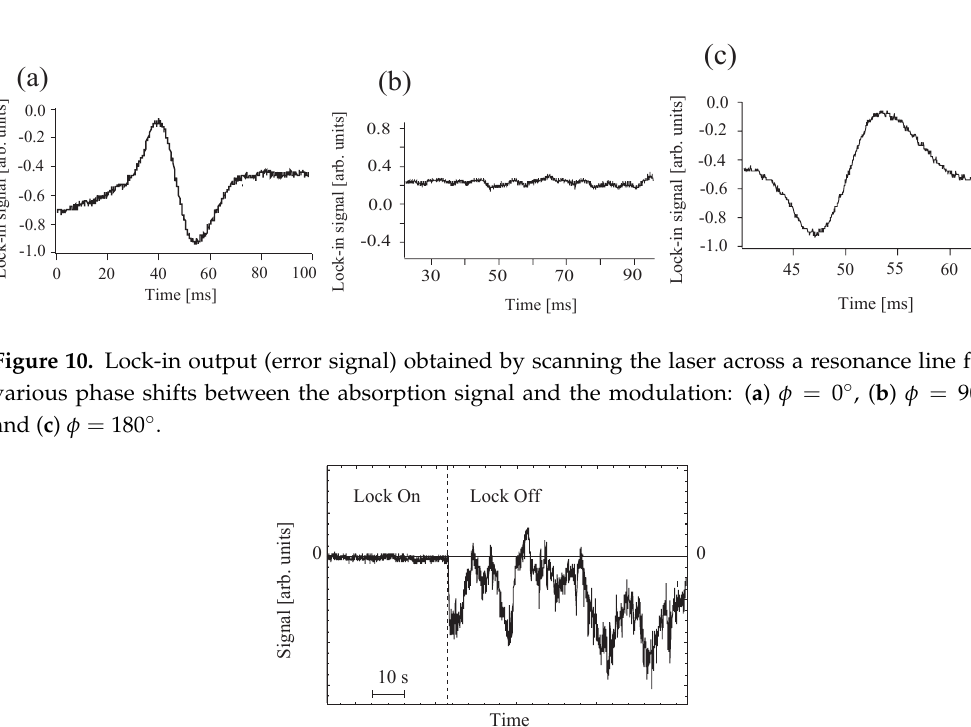
Figure 11. Lock-in error signal recorded with and without engaging the feedback loop. For both parts of the trace, the scan amplitude has been turned off, whereas the modulation remains on. The amplitude variations are mainly due to laser frequency fluctuations, which are greatly reduced with the feedback loop engaged (lock on). Under typical operating conditions, the diode laser remains locked for about 30